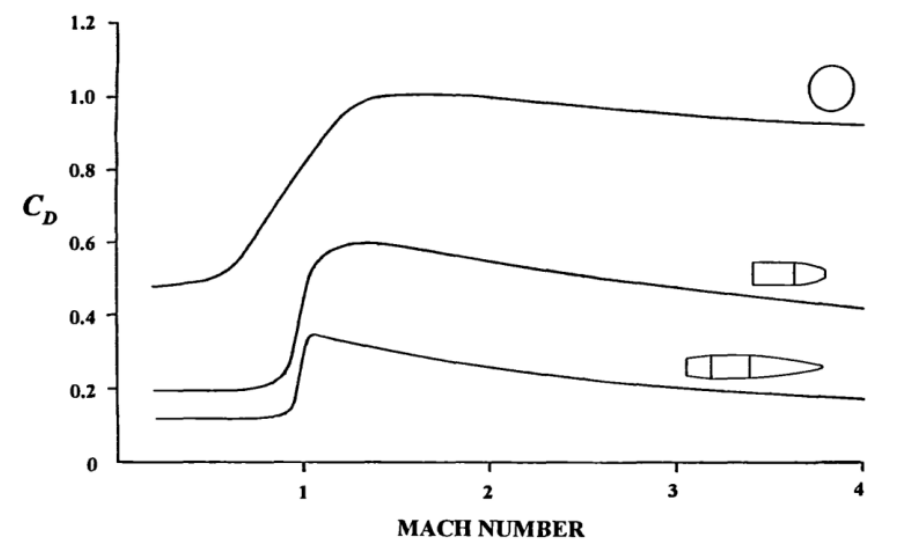
Figure 1. Coefficient of drag as a function of Mach number depending on the shape